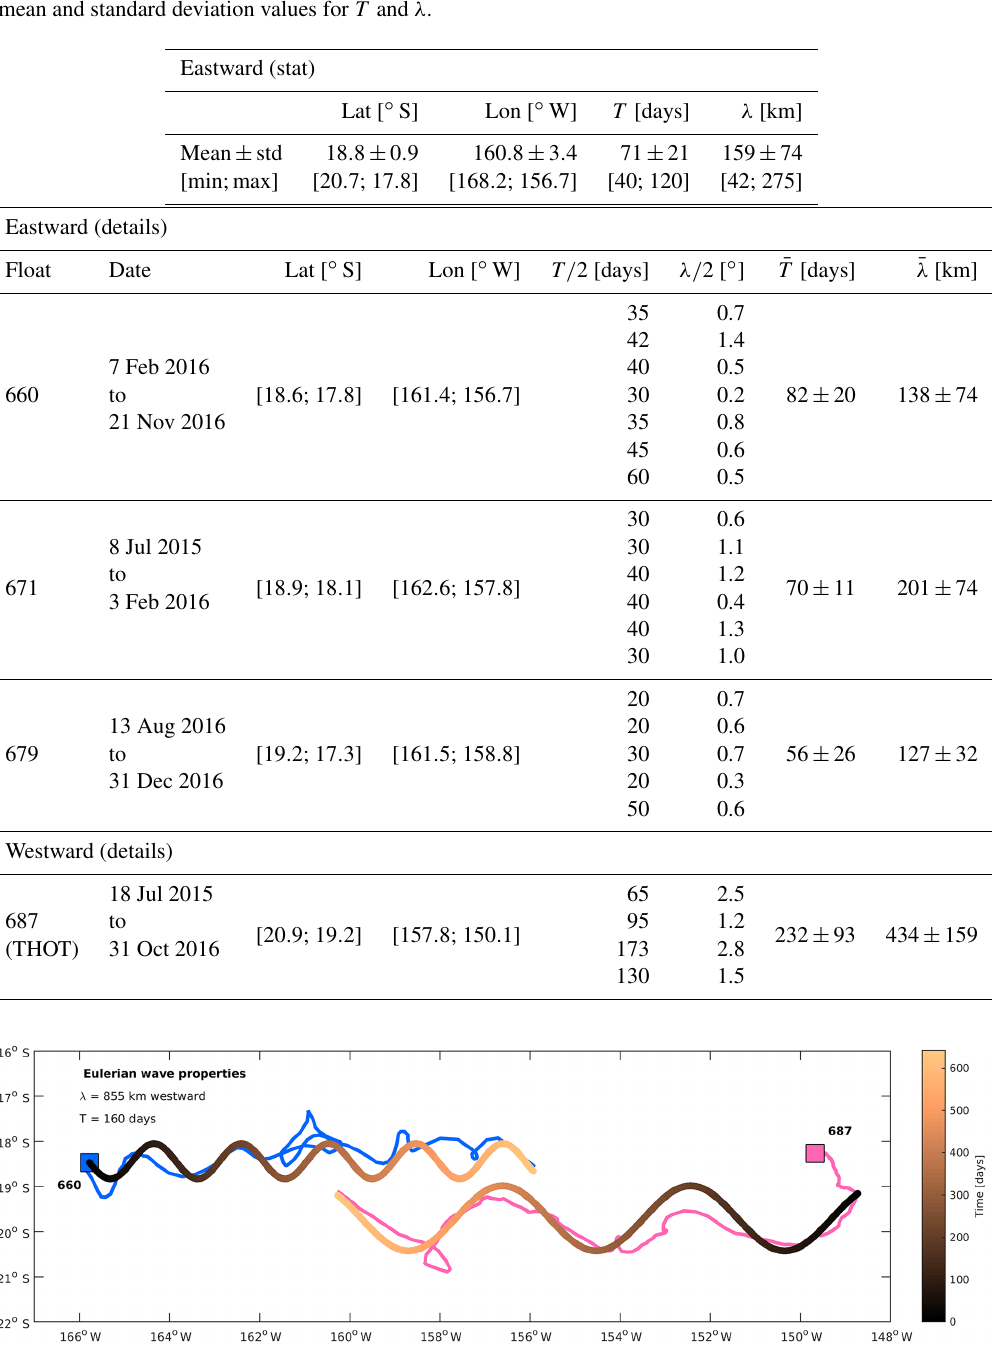
Figure 7. Best analytical solution of Lagrangian trajectories for both floats 660 and 687. The blue line refers to float 660, and the pink one to float 687; the squares refer to their initial location. The black to brown lines refer to the best theoretical solution with a time step of 1